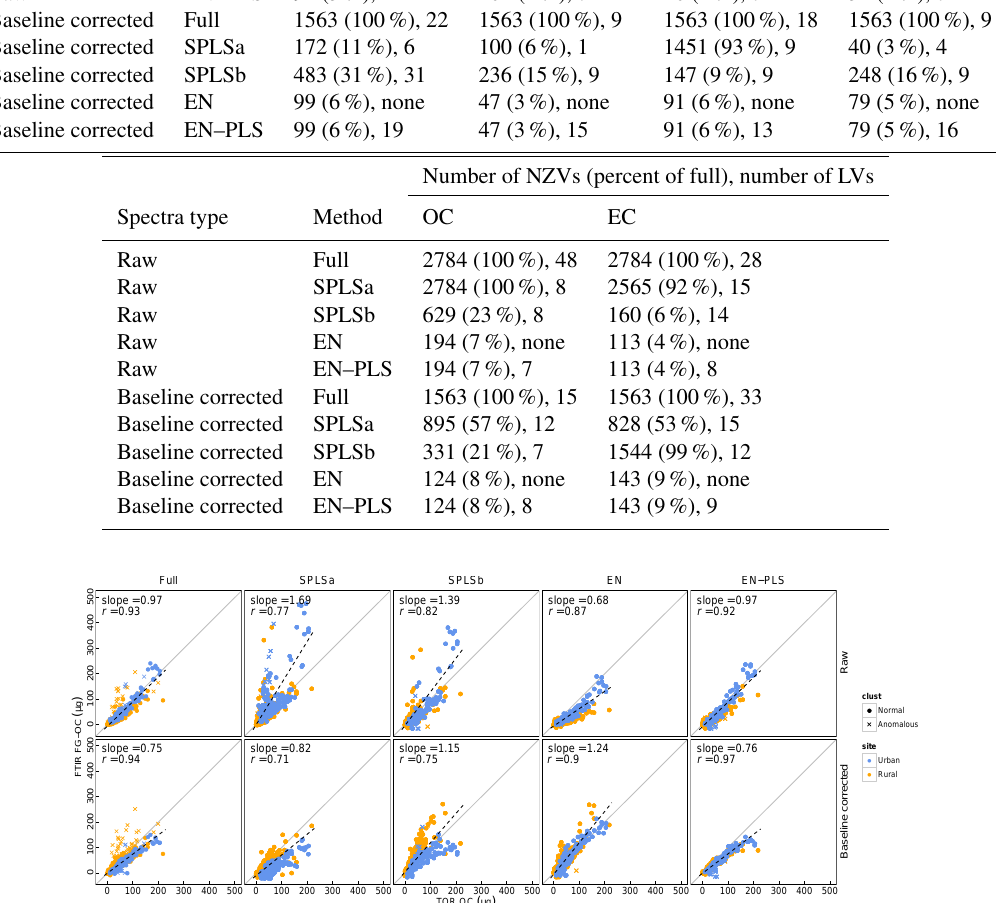
Figure 3. Predictions vs. reference for ambient samples (OC from sum of FG). “Anomalous” samples are those identified by Ruthenburg et al. (2014) (38 samples or 5% of the total set) that share similar spectral profiles and large disagreement with TOR in estimated OC. The cause for the disagreement is at present time